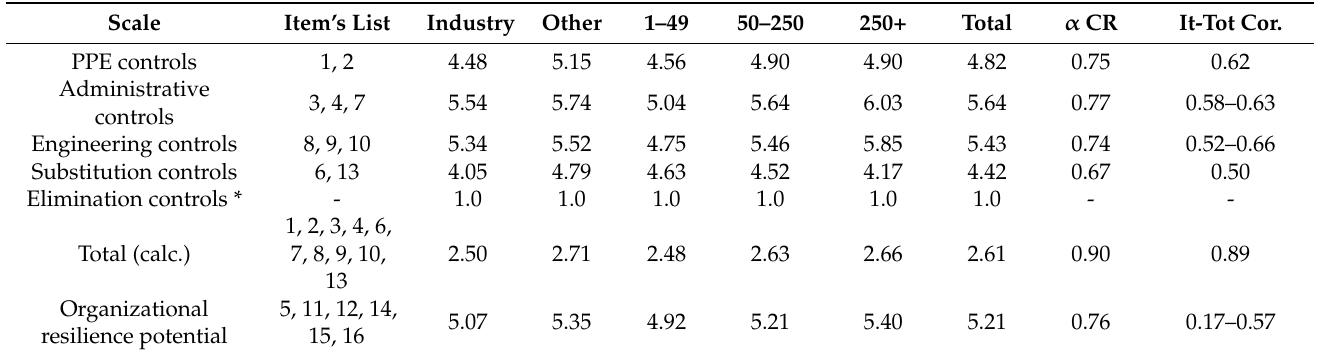
Table 6. Scales of controls and the organizational resilience potential